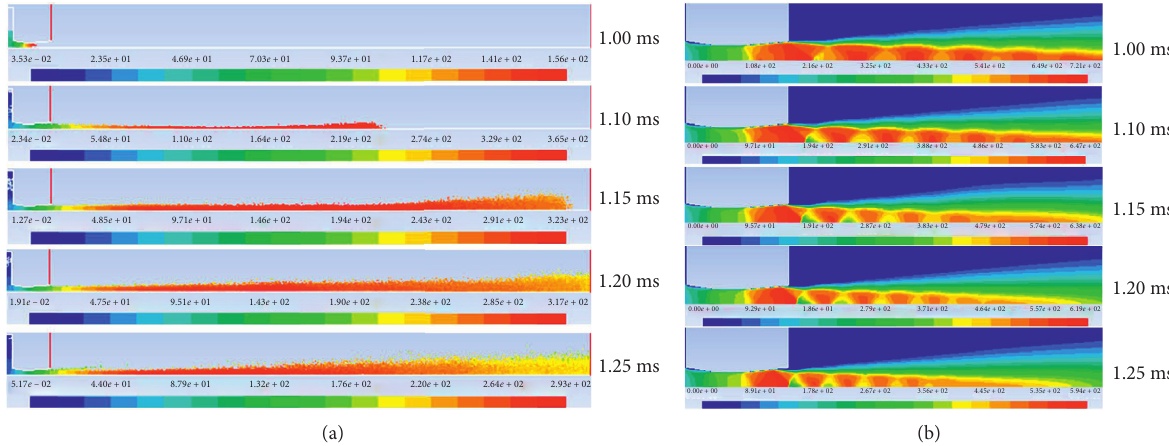
Figure 13: Particle distributions and Mach number contours at the exit of supersonic nozzle. (a) Particle distributions. (b) Mach number contours.